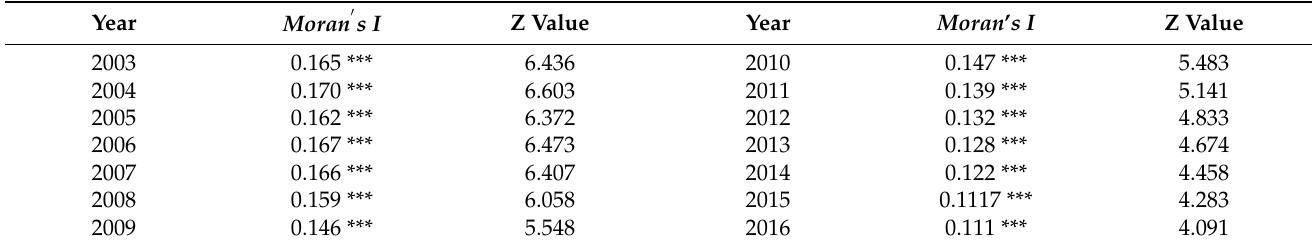
Table 2. Spatial autocorrelation test results of the real GDP of 131cities in the Yangtze River Economic Zone from 2003 to 2016 (Spatial distance weight matrix).